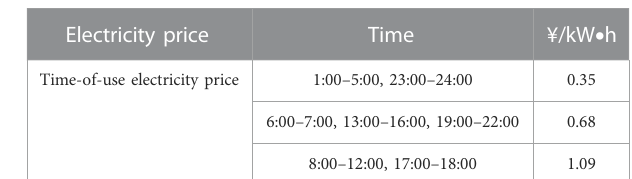
TABLE 3 Electricity price parameters of IES.